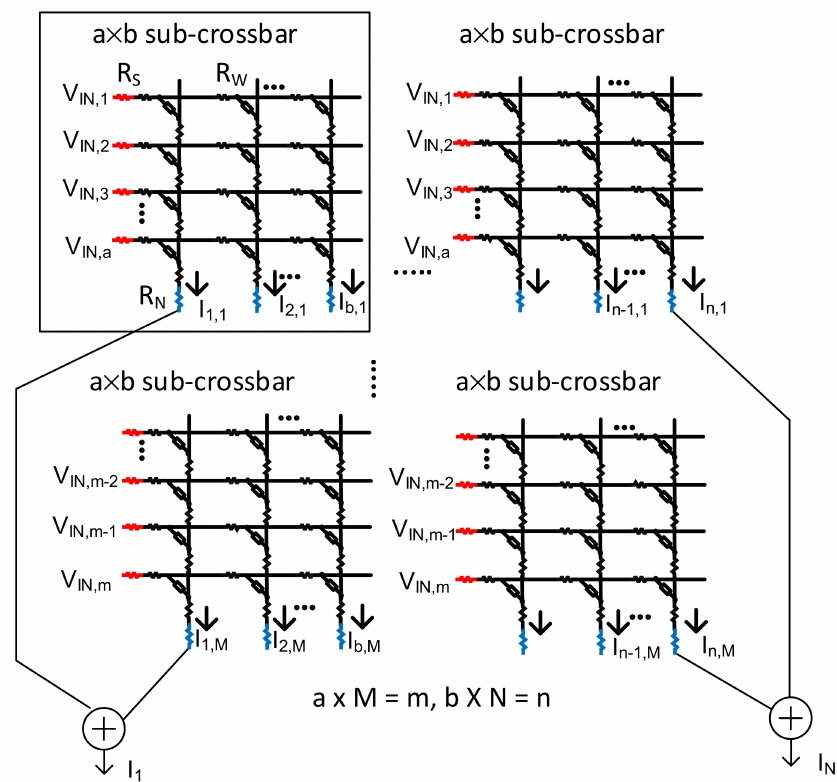
Figure 7. Tile architecture of multiple sub-crossbars for implementing a memristor crossbar with ‘m × n’ cells. Here each sub-crossbar size is ‘a × b’. The numbers of sub-crossbars for rows and columns are ‘M’ and ‘N’, respectively. ‘M’ and ‘N’ can be calculated from ‘m = M × a’ and ‘n = N × b’, respectively. Here RS, RW, and RN are the source, line, and neuron resistance, respectively, contributing to the nonideal effects in the memristor